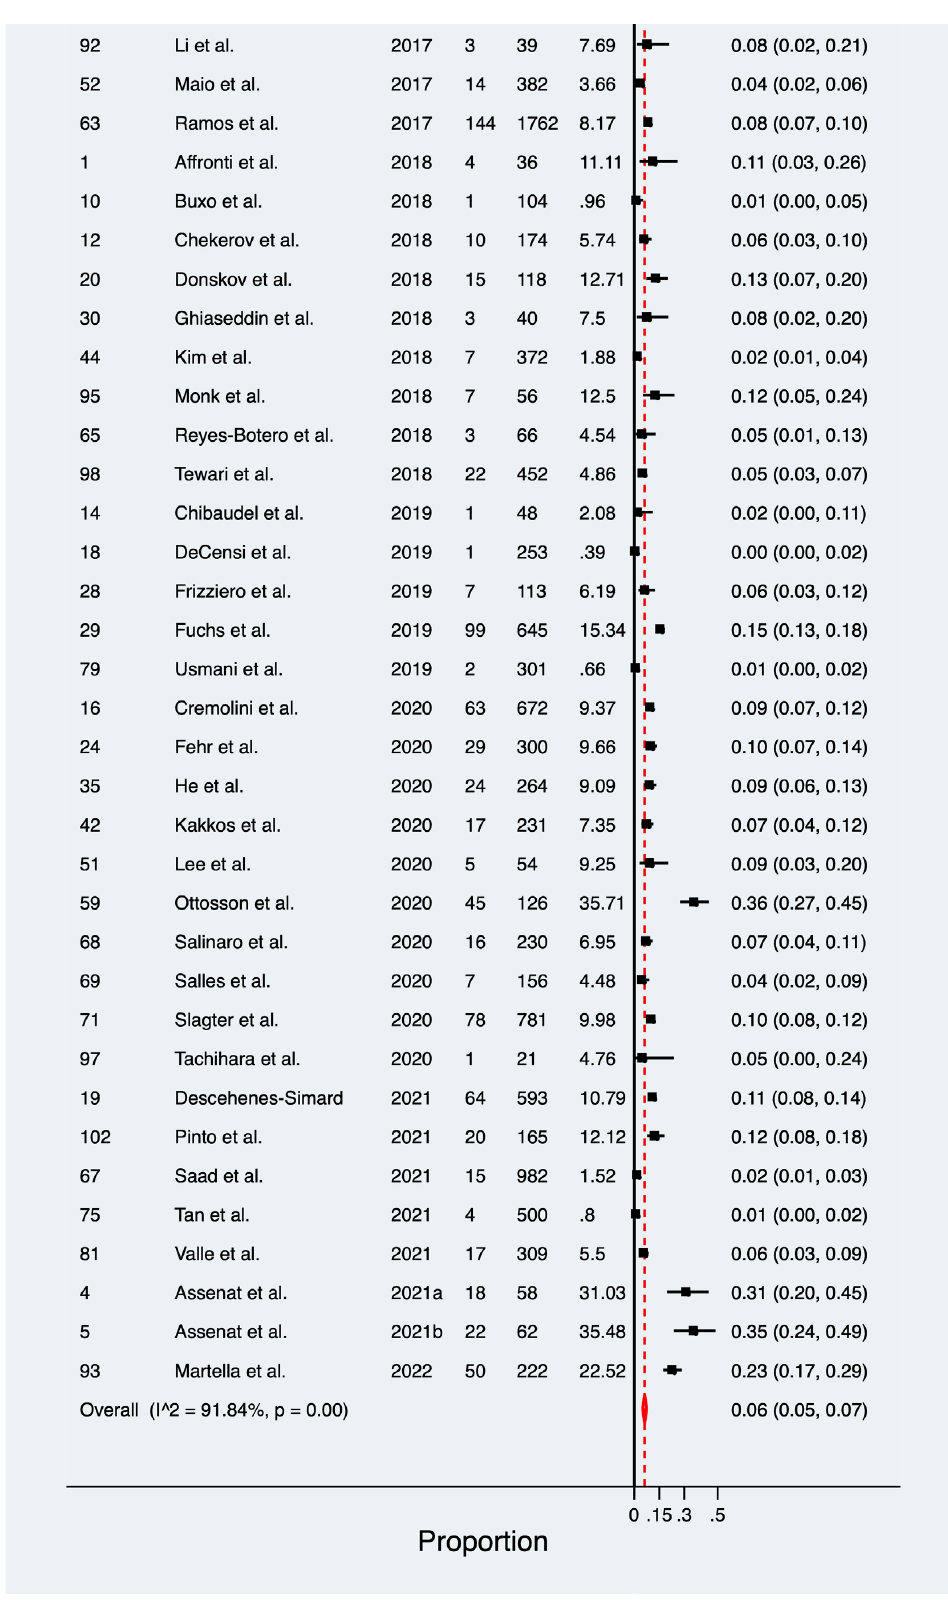
Figure 2. Forest plot showing the estimated overall pooled prevalence of VTE in cancer patients undergoing chemotherapy [29–128]. Abbreviations: VTE: venous thromboembolism.